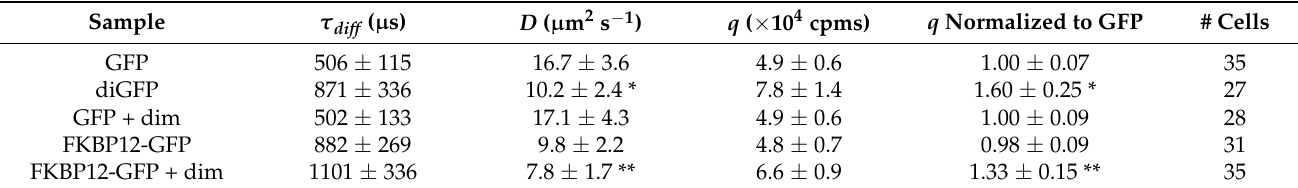
Table 4. Induced dimerization of GFP in cells via the FKBP12